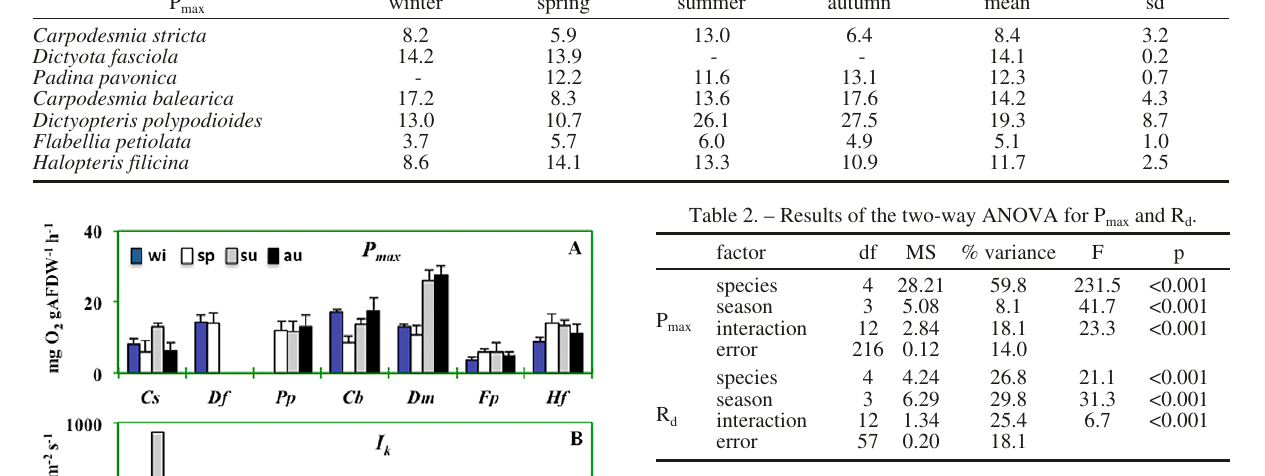
Table 1. – Photosynthesis at saturation (P P max